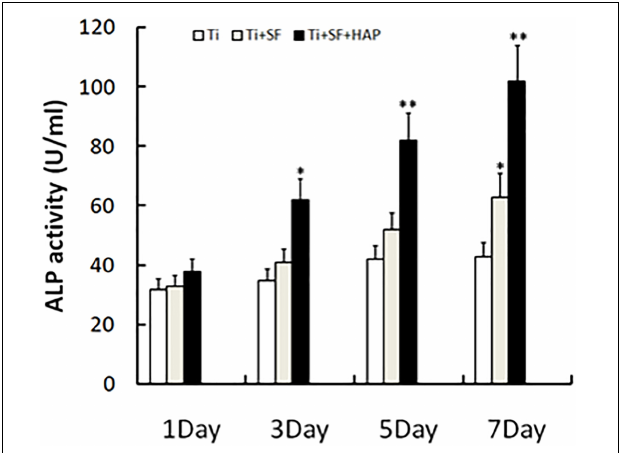
FIGURE 6 | Cell differentiation was monitored by measuring the ALP activity ( ∗ indicates p < 0.05 and ∗∗ indicates p <